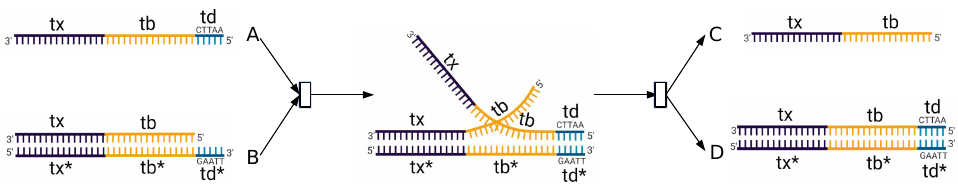
Figure 1. Principle of strand displacement